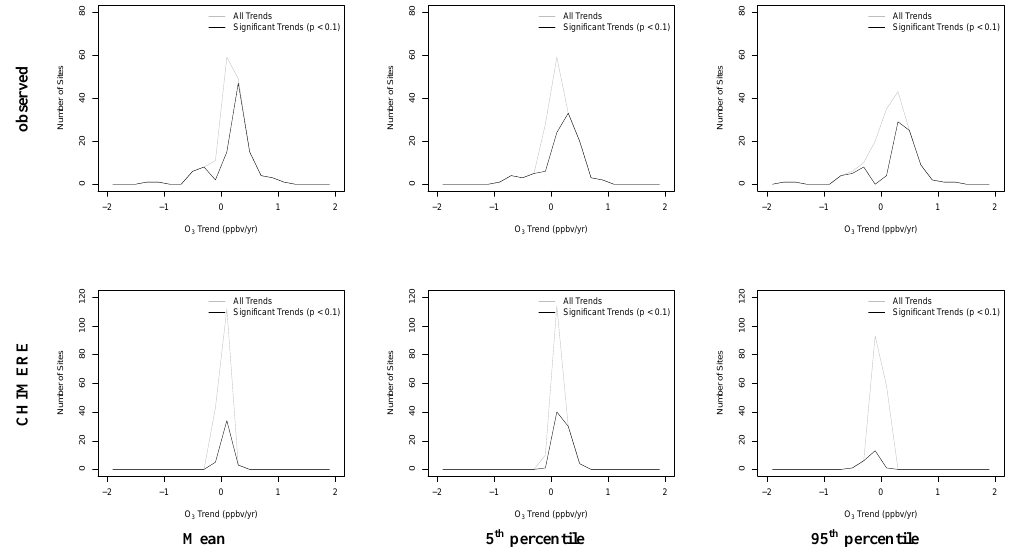
Fig. 14. A comparison of the frequency distribution of annual trends in observed (top) and CHIMERE (bottom) O 3 mean, 5th and 95th percentiles.